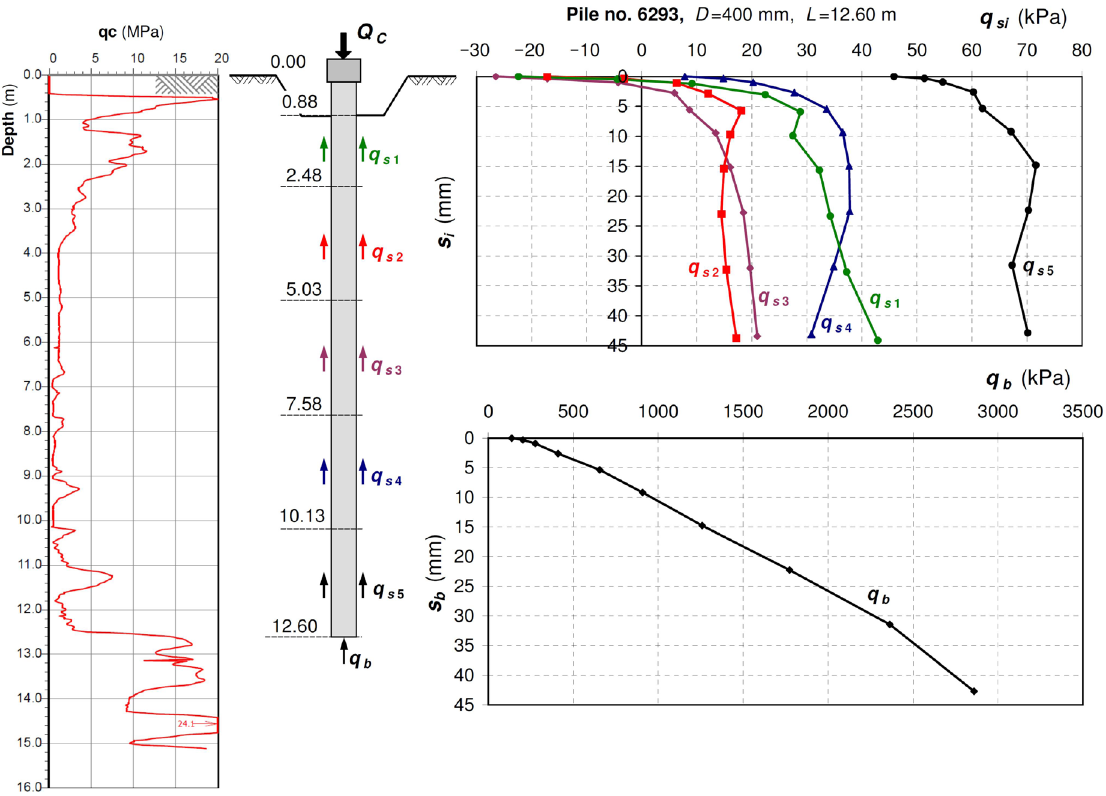
and q unit soil resistances around the pile after taking the residual force into account. s b